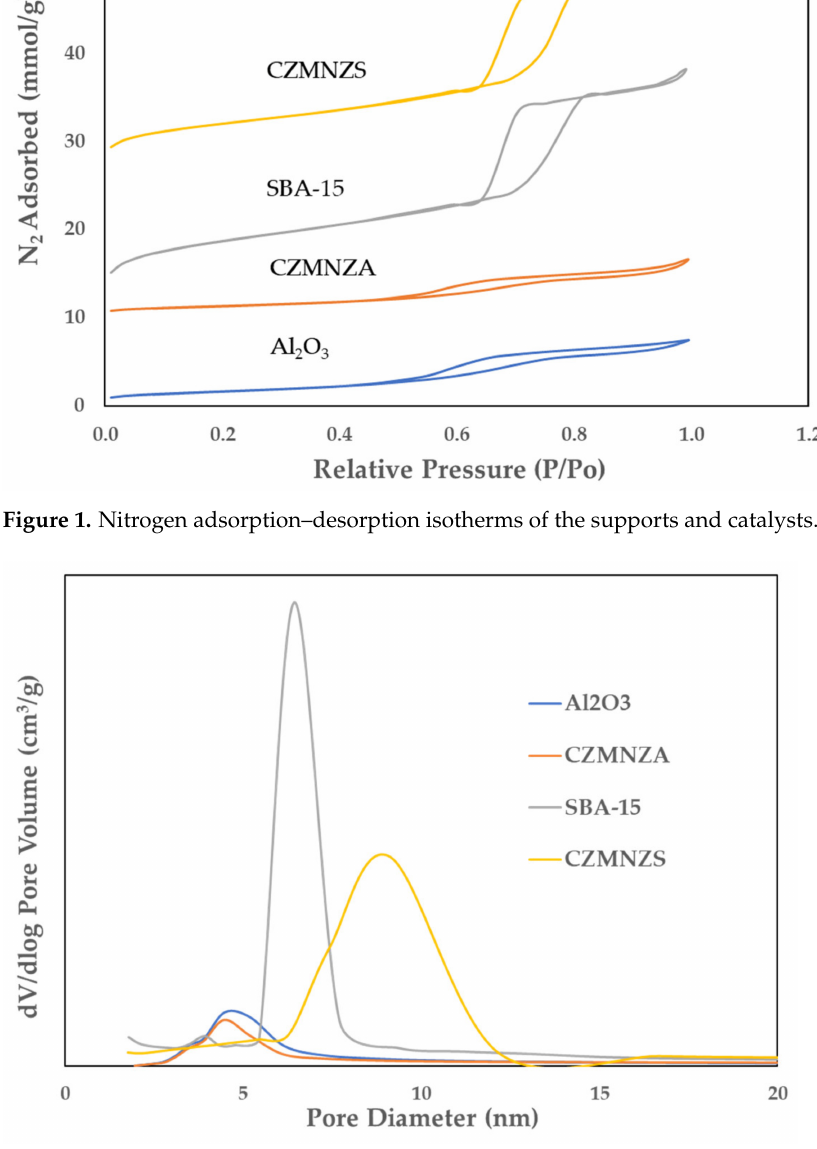
Figure 2. Pore size distributions of the supports and